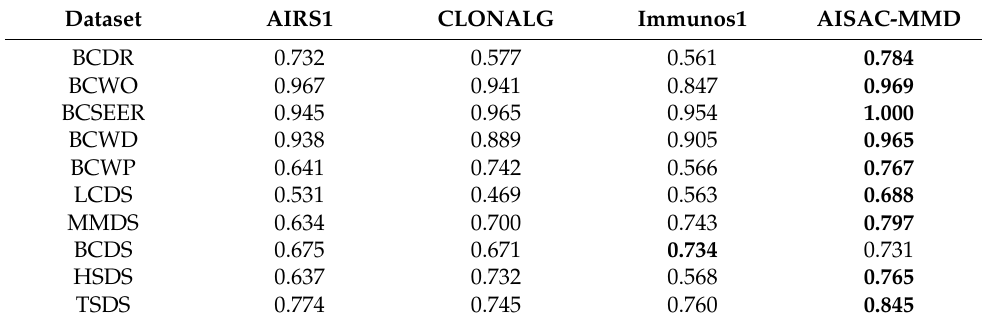
Table 4. Balanced accuracy results for classifiers based on artificial immune systems.